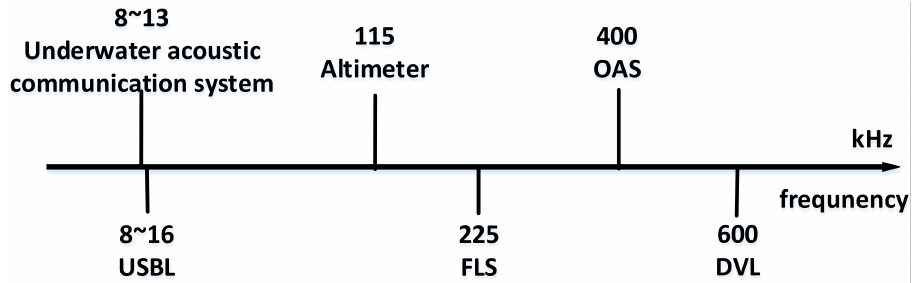
Figure 13. Sonar frequency division